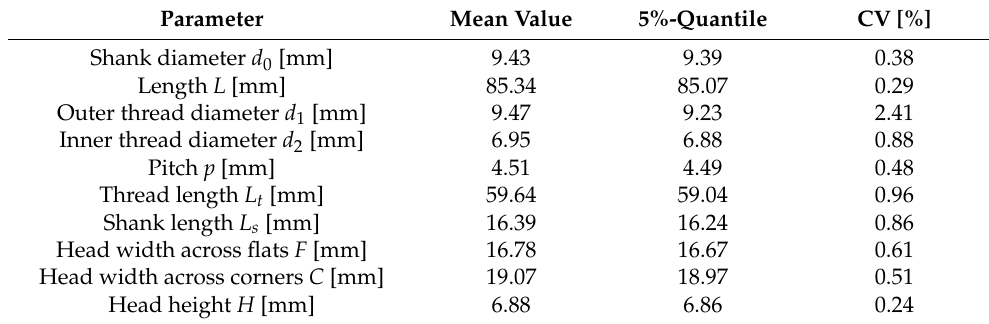
Table 4. Mean values, 5%-quantiles and coefficients of variation for the 10 mm screw used in the tests.